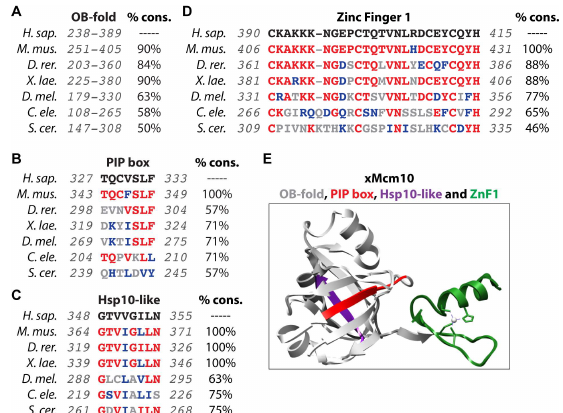
Figure 2. Evolutionary conservation of functional domains in the Mcm10 ID. ( A – D ) Comparison of the amino acid sequences from Homo sapiens , Mus musculus , Danio rerio , Xenopus laevis , Drosophila melanogaster , Caenorhabditis elegans , Saccharomyces pombe and Saccharomyces cerevisiae of the OB-fold ( A ), PIP box ( B ), Hsp10-like ( C ) and Zinc-Finger 1 ( D ) domains. The full sequence alignment for the OB-fold is not shown due to size constraints, but can be found in Warren et al., [70]. The percent conservation (% cons.), defined as the percentage of amino acid positions identical (in red) or strongly similar (in blue) to those of human Mcm10, is listed for each domain sequence. The total region aligned for each sequence listed in gray. ( E ) The crystal structure of the Xenopus Mcm10 (xMcm10) OB-fold (gray), PIP box (red), Hsp10-like (purple) and Zinc-Finger 1 (green) domains is shown. The structure was generated using pdb data file 3EBE and the Chimera program (http://www.cgl.ucsf.edu/chimera)